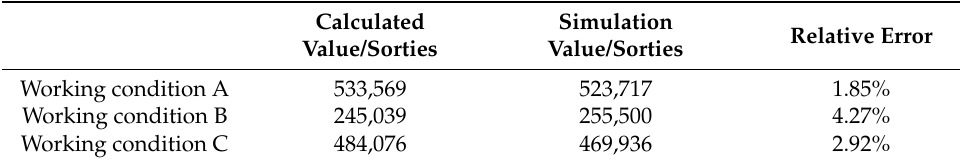
Table 8. Model validation